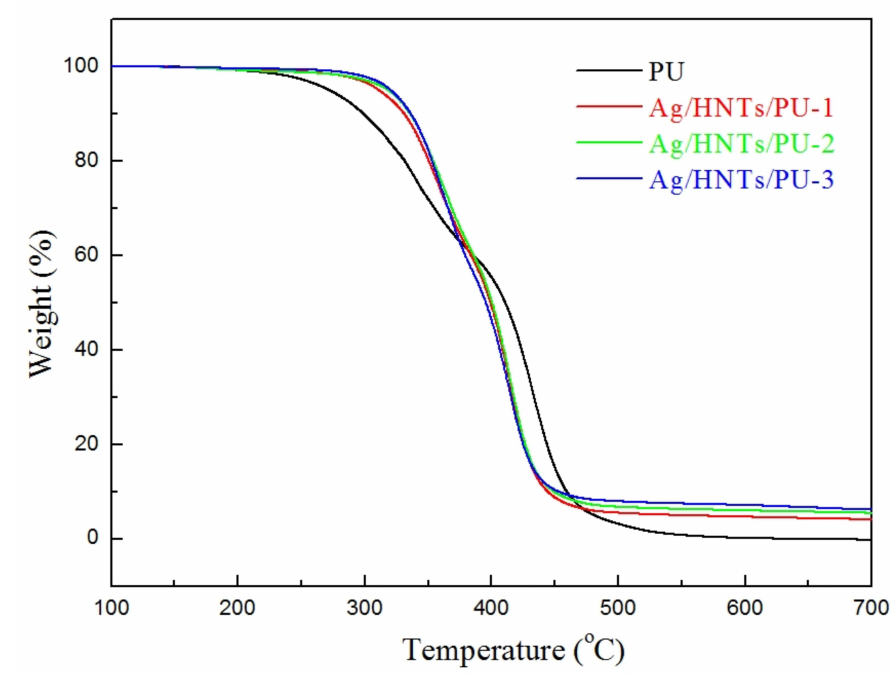
Figure 6. Thermal gravimetric analysis (TGA) curves of the Ag / HNTs / PUs.